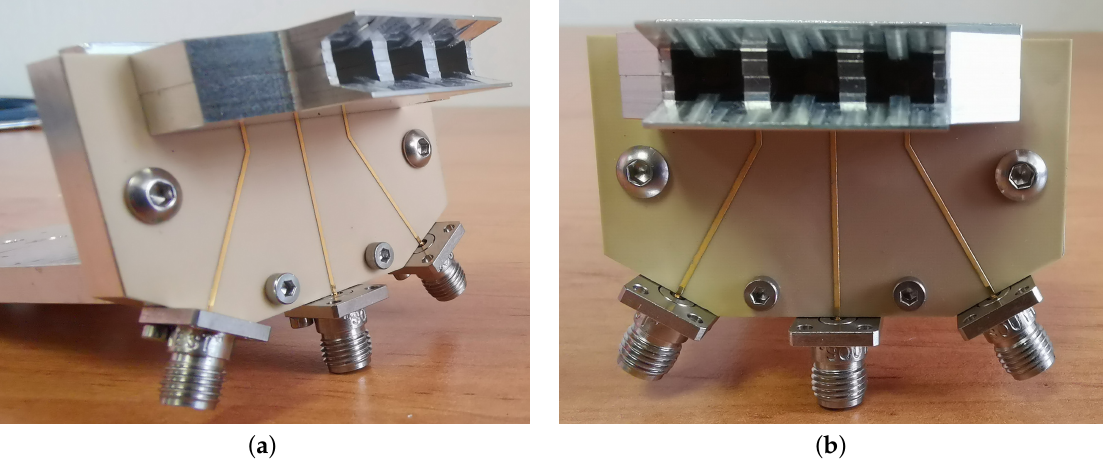
Figure 4. Manufactured sample of the antenna array: ( a ) side view and ( b ) front